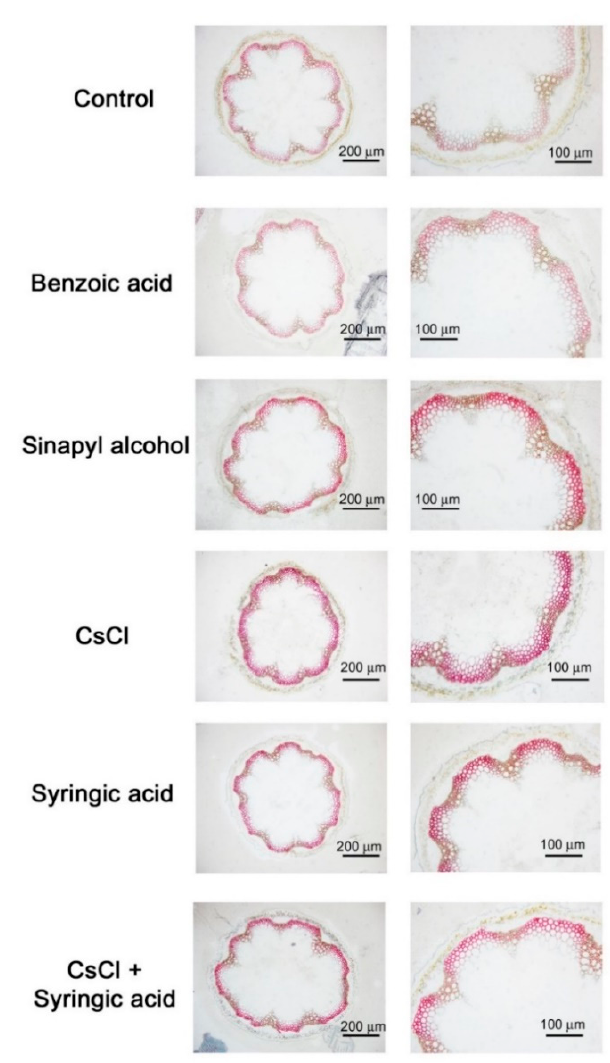
Figure 4. Histochemical analysis of lignin deposition in Arabidopsis stems. Soil-grown Arabidopsis plants were treated with Milli-Q water as a control, syringic acid, sinapyl alcohol, benzoic acid, CsCl, or a combined treatment of CsCl and syringic acid. The cryosectioned samples were 20 µ m thick and stained for syringyl lignin. Images were analyzed and digitally photographed under an optical microscope.